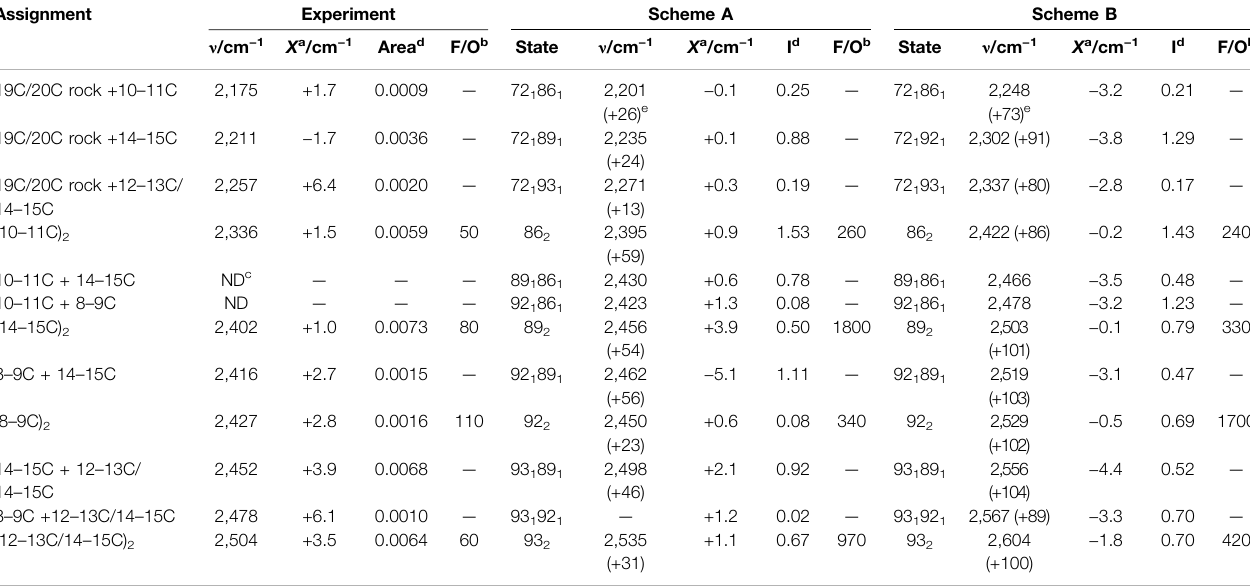
TABLE 2 | Assignment of bands to overtone and combination vibrational transitions of the retinal in the BR state. Experiment Scheme